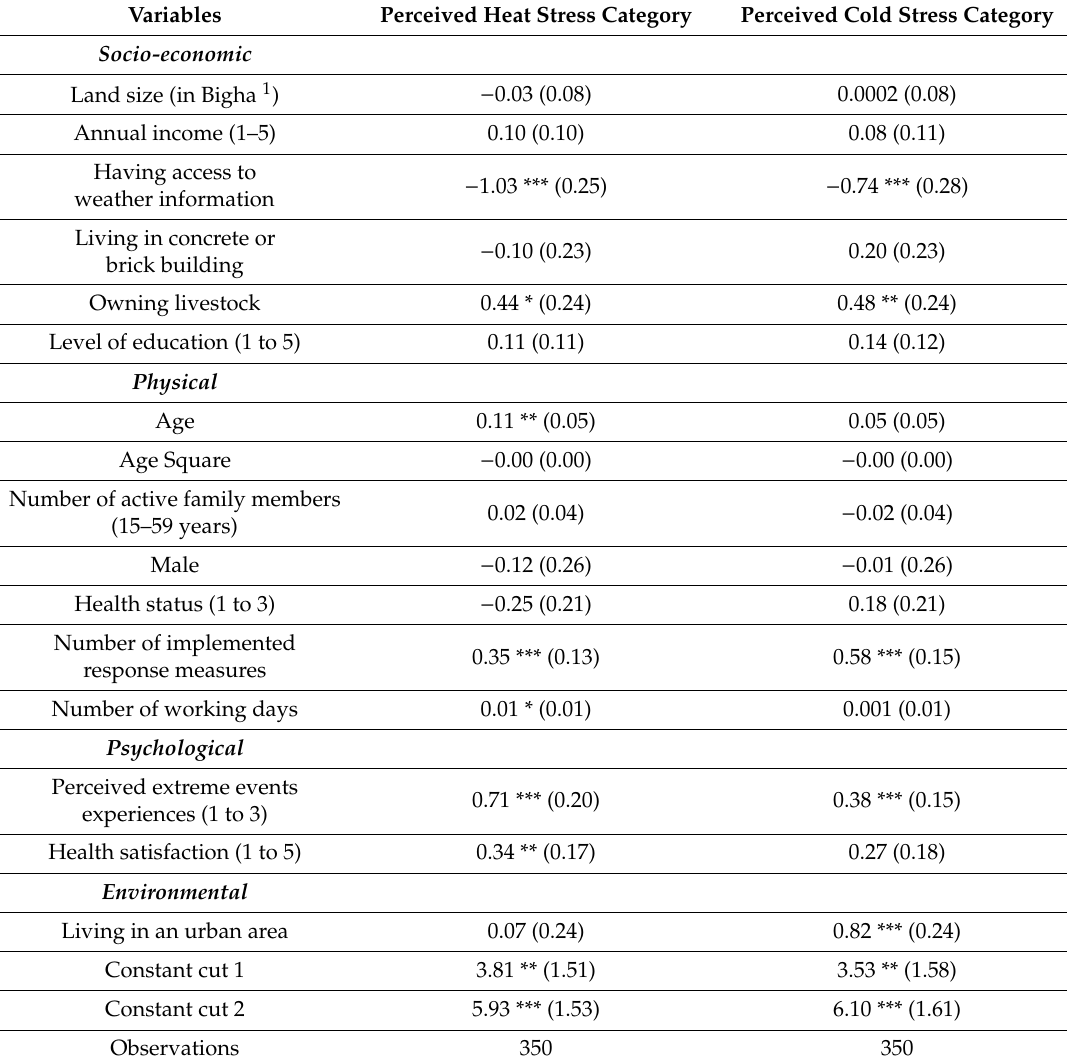
Table 3. Results of ordered logit model with the dependent variables being the level of heat stress and cold stress (from 1 very low to 3 very